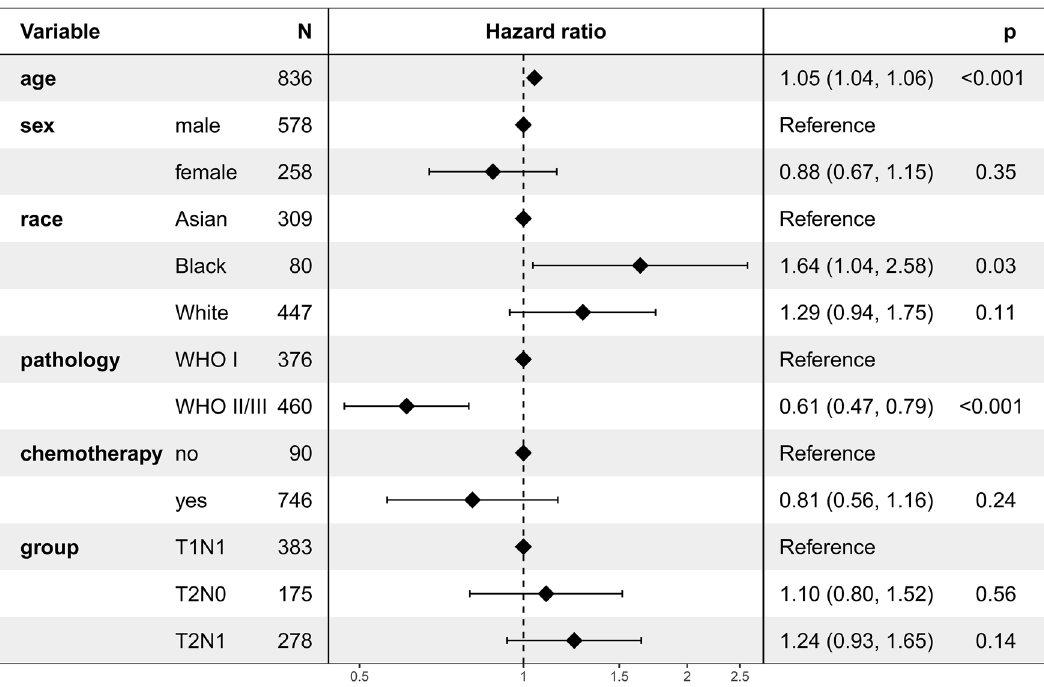
Figure 3. Multivariate regression analysis of the prognostic factors for overall